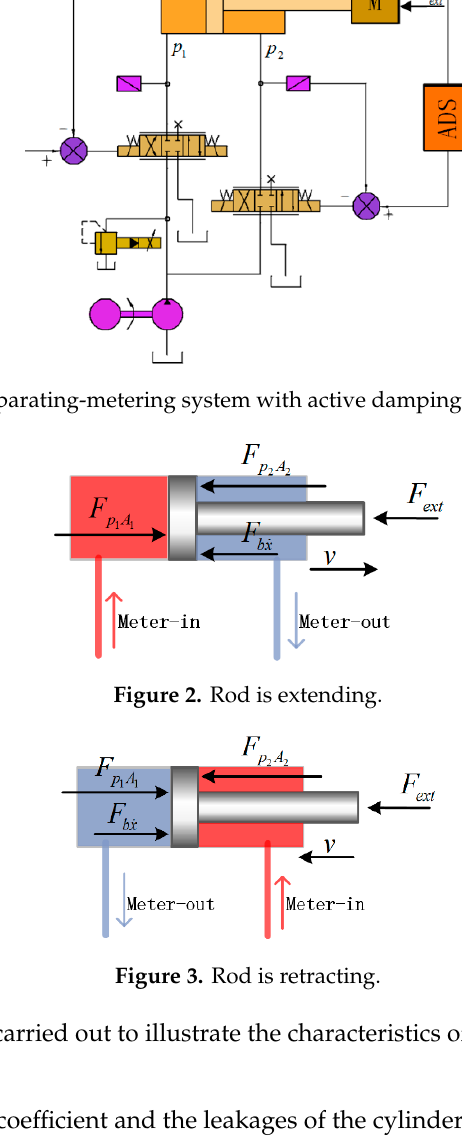
Figure 1. Separating-metering system with active damping strategy (ADS).